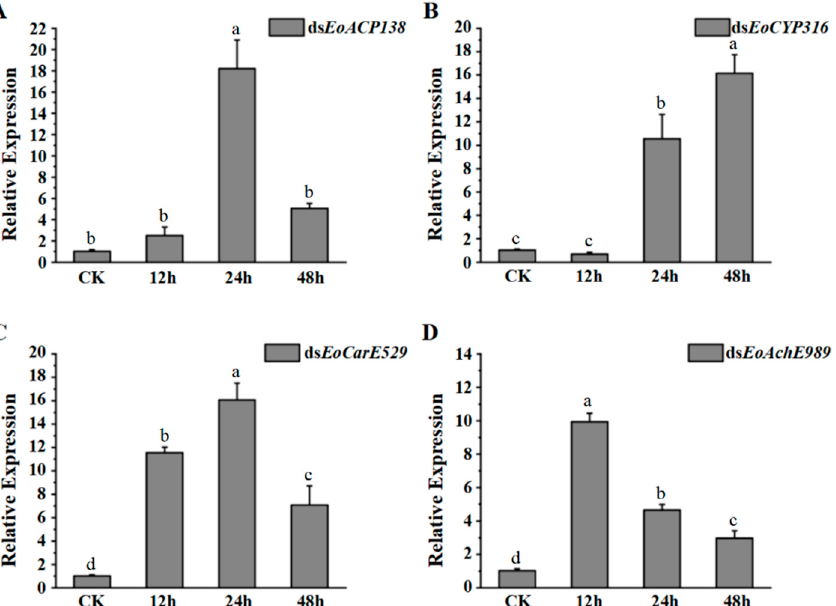
Figure 1. The gene expression of fourth instar larvae after deltamethrin was stimulated. ( A ) EoACP138 ( B ) EoCYP316 ( C ) EoCarE592 ( D ) EoAchE989 . Where CK was the 0 h treatment control, and 18S rRNA was used as the internal reference gene for qRT-PCR with three replicates per treatment. Each bar represents the mean ± SD. Different letters indicate significant differences ( p < 0.05) by using the Tukey test to compare in ANOVA.